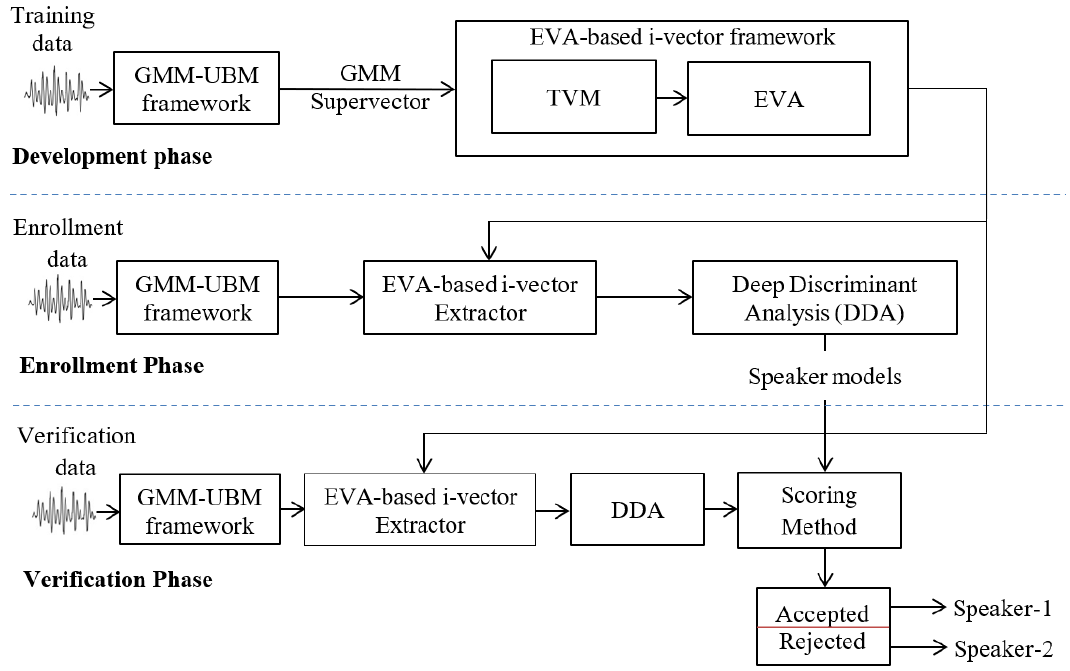
Figure 1. The proposed speaker verification system in development, enrollment, and verification